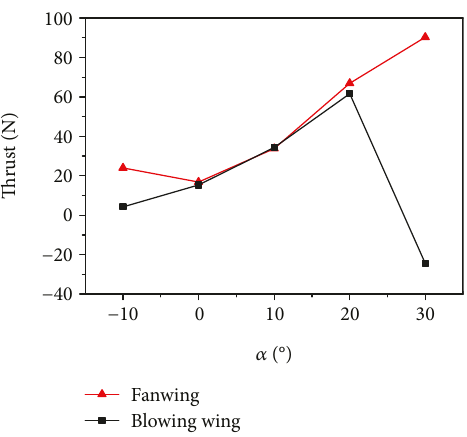
Figure 17: Thrust curve changes with the angle of attack.